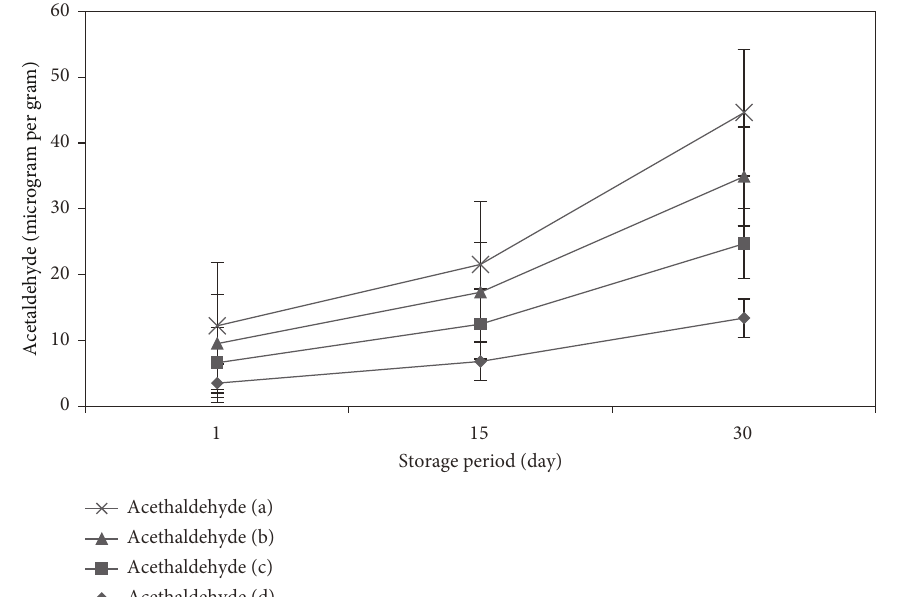
Figure 7: Changes in acetaldehyde ∗∗ ( µ g/g) during storage of Iranian UF cheese ∗ treated by KCl and NaCl during 30days of storage period. ∗ (a) 3% NaCl (control), (b) 1.50% NaCl+1.50% KCl, (c) 1.00% NaCl+2.00% KCl, and (d) 0.75% NaCl+2.25% KCl. ∗∗ means at the same age differed significantly (( P < 0 .